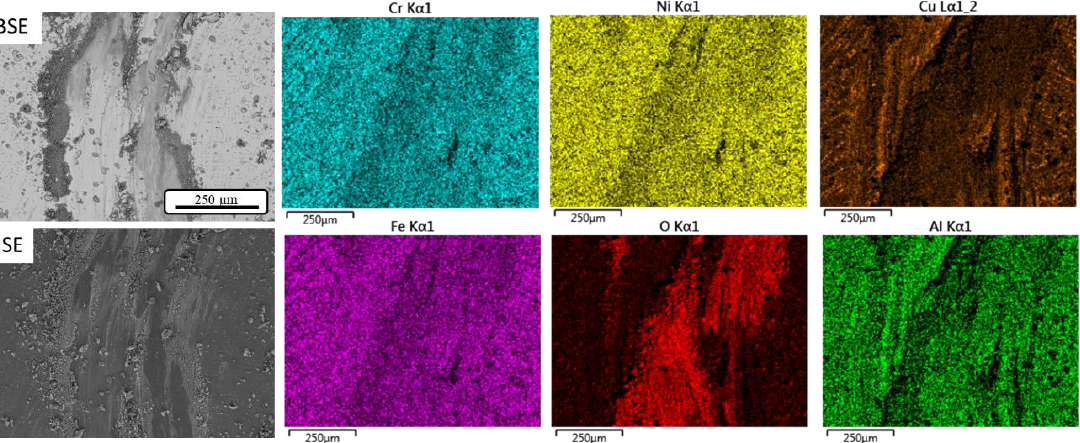
Figure 7. BSE and SE images and corresponding EDS elemental maps of the A2 alloy wear track after 300 °C sliding.